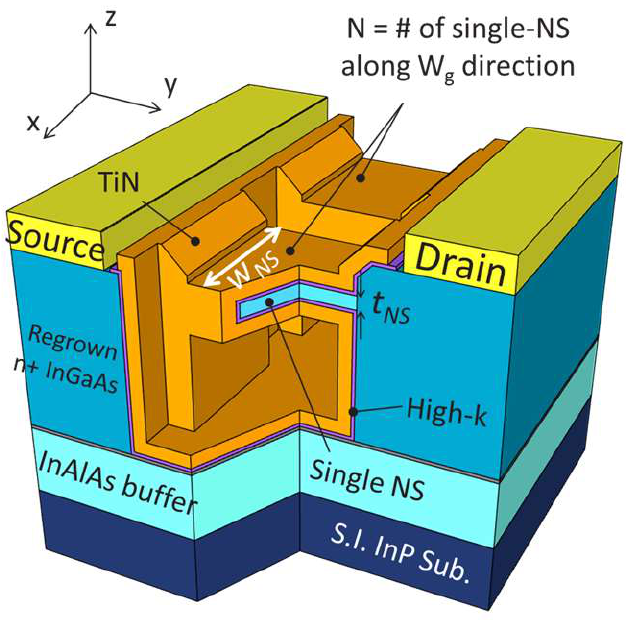
Figure 1. The 3D cross-sectional schematic of a GAA In 0.53 Ga 0.47 As NS MOSFET that is in this work, together with geometrical definitions such as W NS and t NS .